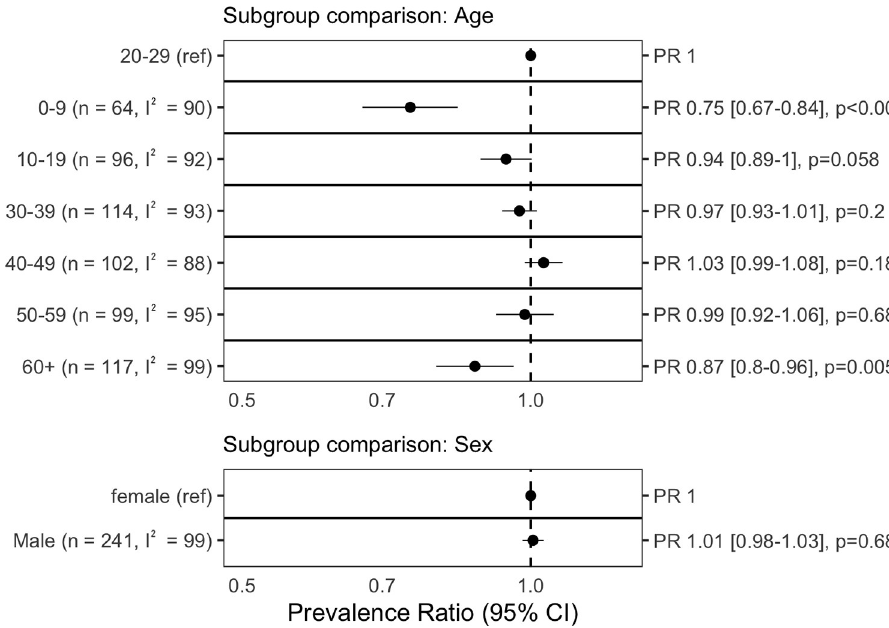
Fig 3. Meta-analysis of seroprevalence differences by demographic groups. We calculated the ratio in prevalence between subgroups within each study then aggregated the ratios across studies using inverse variance-weighted random-effects meta-analysis. Each row represents a separate meta-analysis. I 2 , heterogeneity quantified using the I 2 statistic; PR, prevalence ratio.